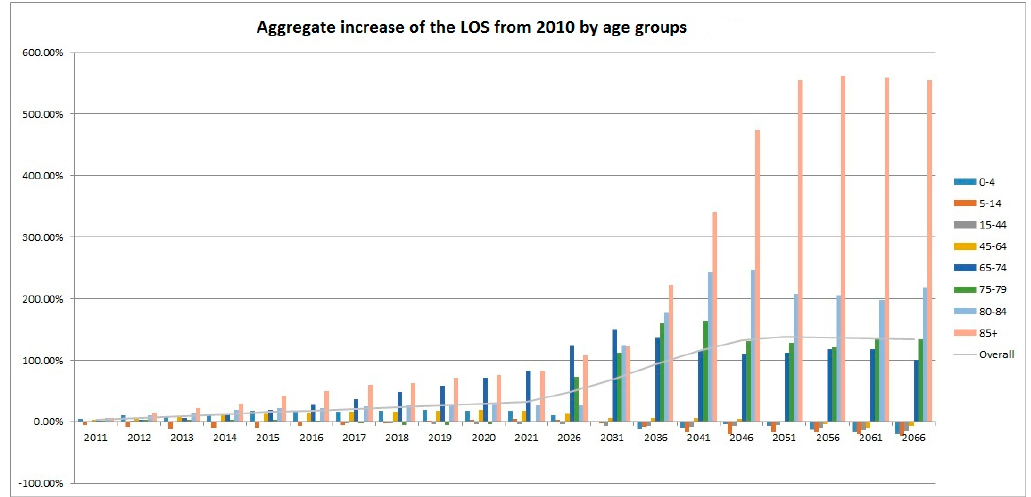
Figure 3. Aggregate increase in the LOS from 2010: 2011–2066. Int. J. Environ. Res. Public Health 2018 , 15 , x